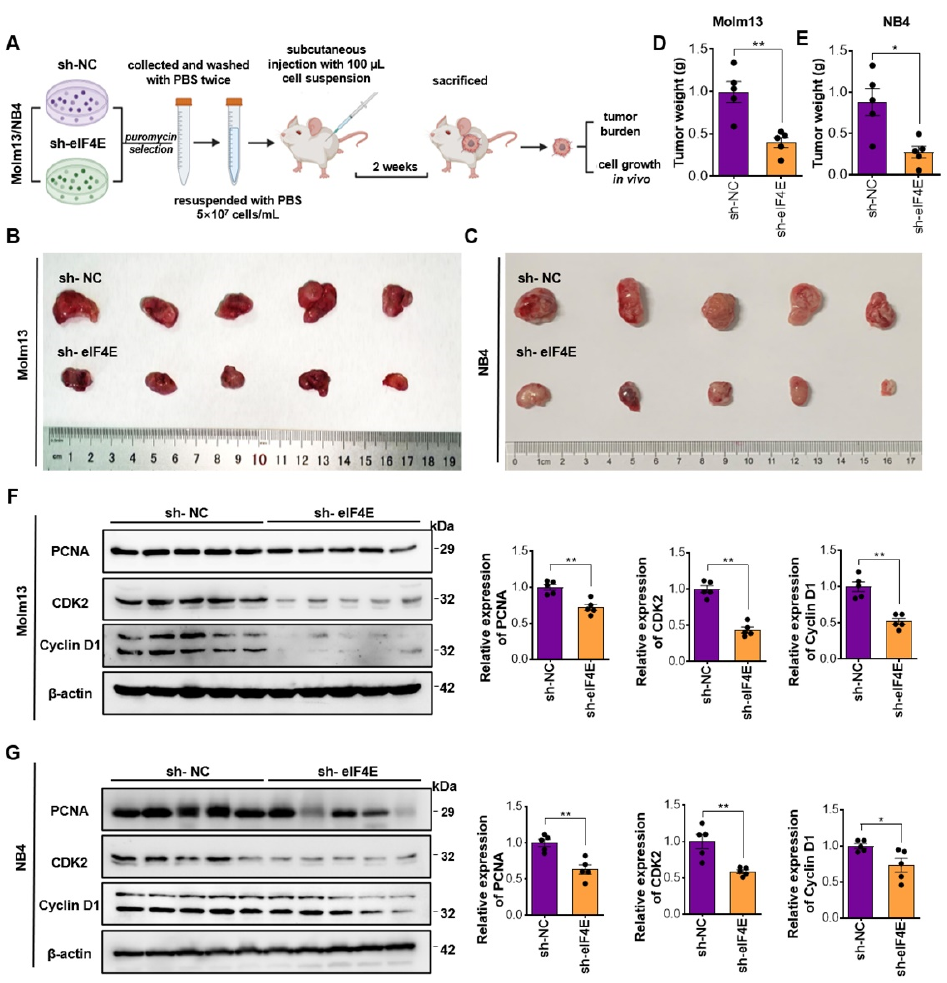
Figure 3. eIF4E knockdown blocked the AML cell growth in vivo. ( A ) Schematic representation of in vivo AML xenograft experiment. M-NSG mice received subcutaneous injection with 5 × 10 6 indicated Molm13 cells. ( B , C ) Two weeks after the injection, the mice were sacrificed and the tumors were removed and photographed. ( D , E ) AML xenograft tumor burden was analyzed by weighting the tumors. ( F , G ) The cell proliferation of AML cells in vivo was assessed by the protein level of PCNA, CDK2, and CyclinD1. Total proteins were extracted from tumor tissues and subjected to western blot. * p < 0.05, ** p < 0.01.